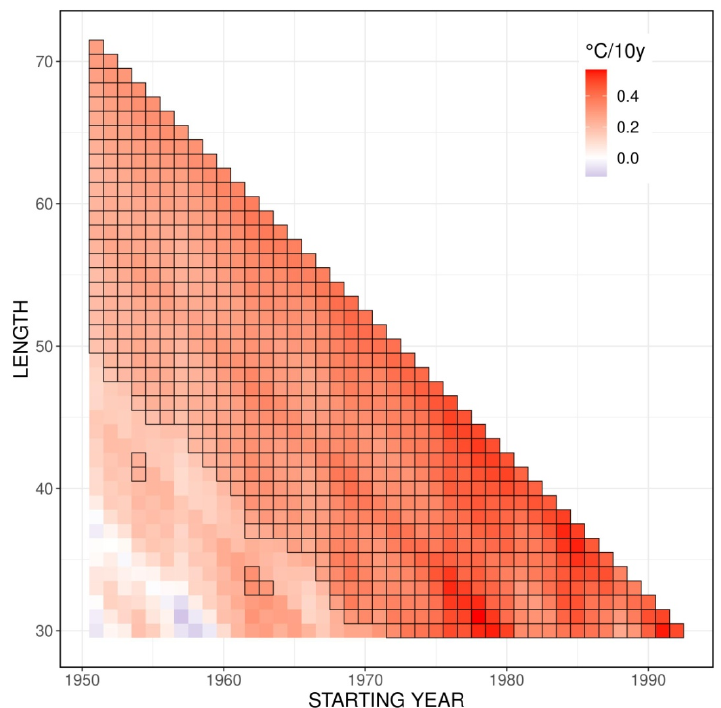
Figure 5. Trend coefficients (significant at the 0.05 level; MK tests are outlined) of the average annual air temperature in Poland for a given start year, and length of the analyzed period.